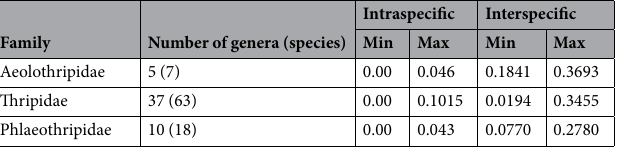
Table 1. Mean K2P genetic distance of different families under study. The family Stenurothripidae is not included here as it is represented by one